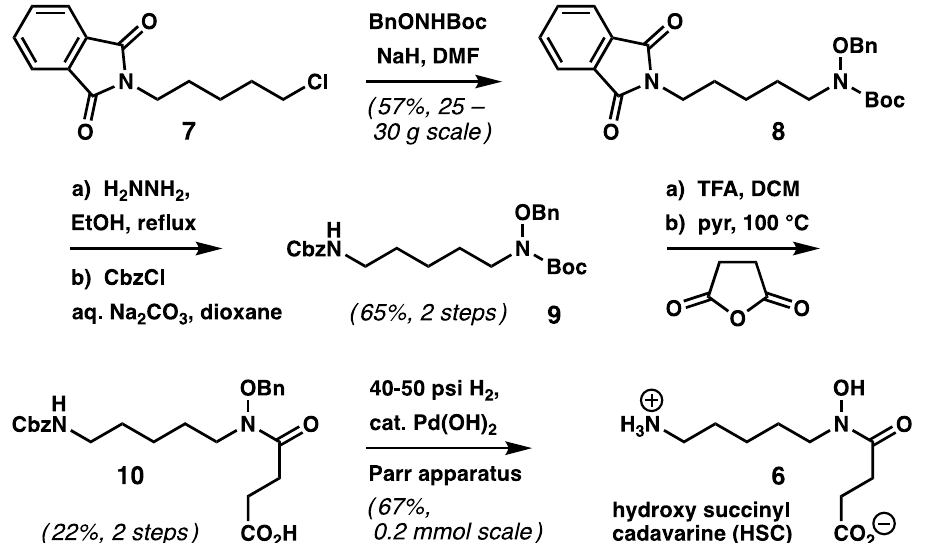
Scheme 2. Multigram synthesis of HSC featuring a modified global deprotection and purification.